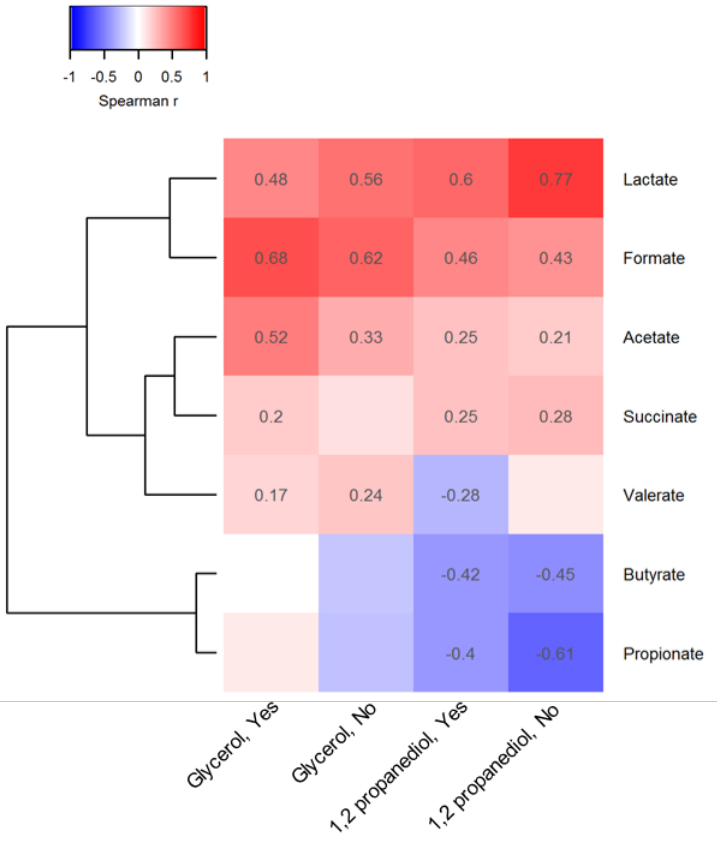
Figure 2. Association between observed 1,2 propanediol and glycerol and representative metabolites. In cells Spearman coefficients with p -value lower than 0.05 are displayed. The absence of spearman coefficients represents statistical insignificance ( p > 0.05). To the bottom of the heatmap, “Yes” or “No” indicates whether or not vitamin D supplements were used before 3 months of age. The dendrogram tree to the left side of the heatmap indicates clustering of taxa based on Euclidean